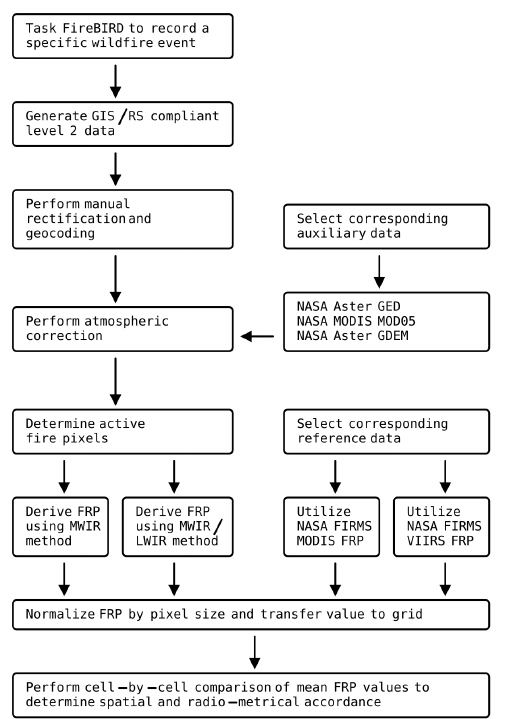
Figure 1. Schematic representation of the processing